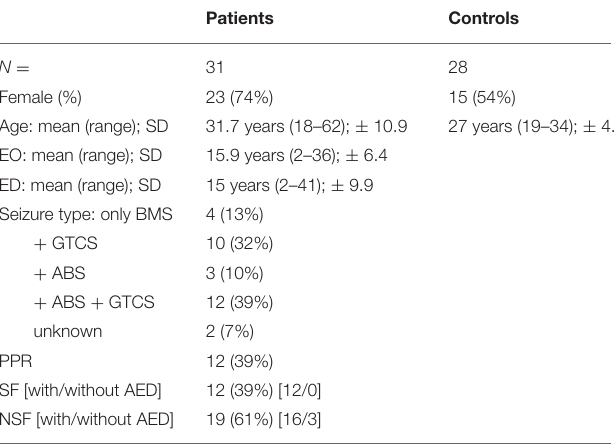
TABLE 1 | Clinical data of all patients and controls included in the